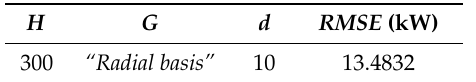
Table 1. The modelling parameters of the optimum ELM architecture.